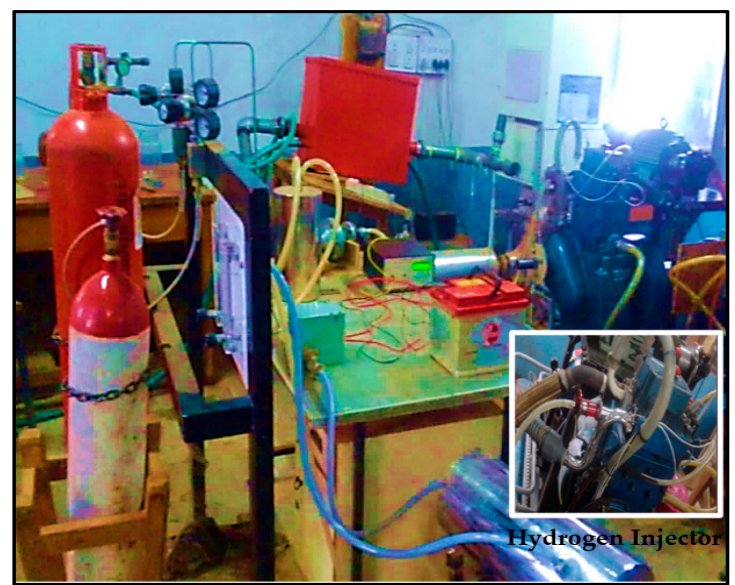
Figure 4. Photographic view of dual fuel engine test rig provided with hydrogen injection.